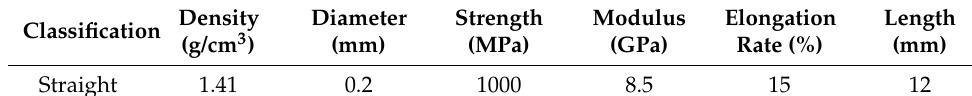
Table 2. Physical and mechanical properties of POM fiber.